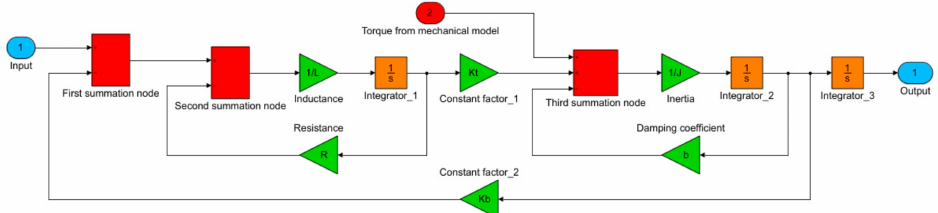
Figure 13. Model of a DC motor made by the method of block diagrams. A signal was added to the motor model with the value of the driving torque needed to realize the dynamics of the remote center of motion mechanism of the surgical